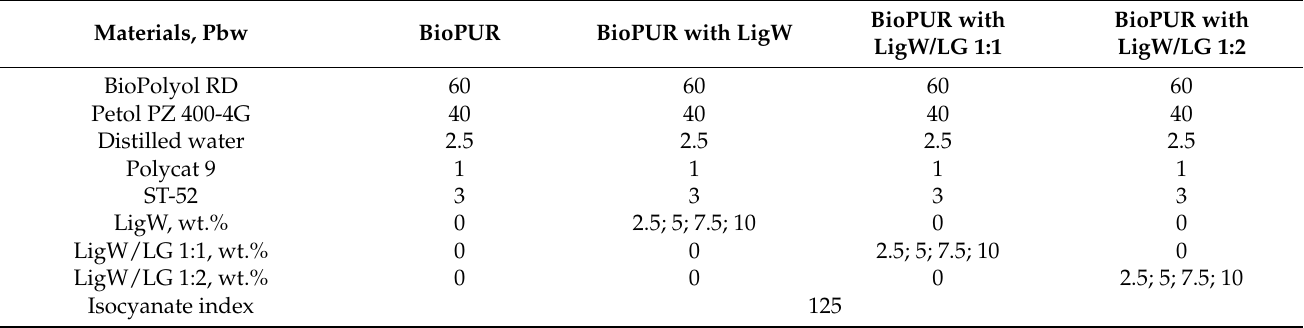
Table 1. Composition of BioPUR